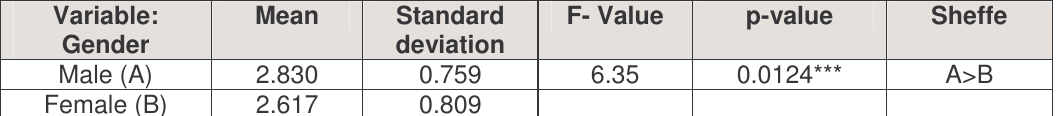
Table 5: ANOVA between gender groups regarding support (partners and advisors)